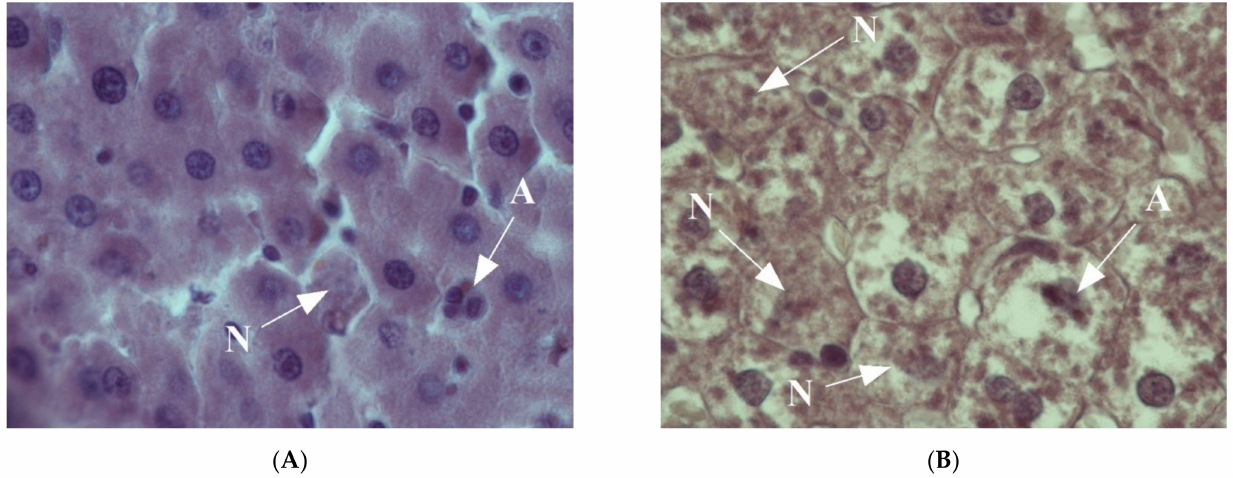
Figure 2. Livers of rats: ( A )—Control; ( B )—EtOH + CL. Arrows show the cells in conditions of: A—apoptosis; N—necrosis. Hematoxylin–eosin staining, ×